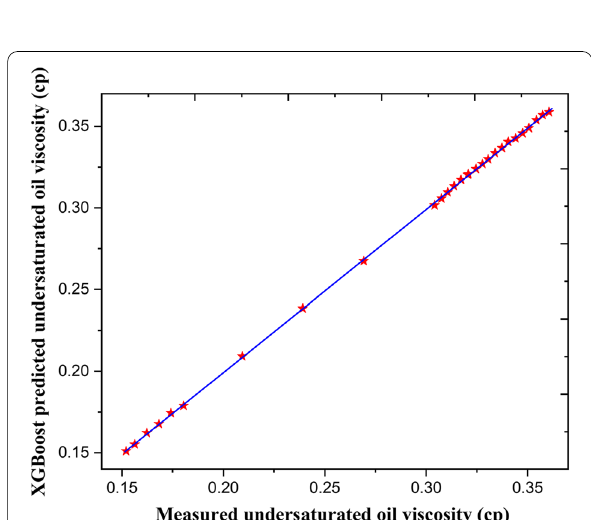
Fig. 17 Cross plot of AdaBoost-SVM predicted values versus measured